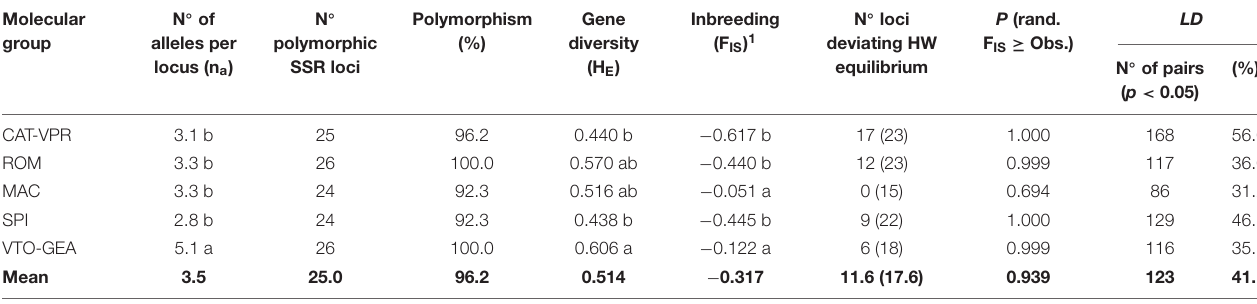
TABLE 2 | Descriptive genetic statistics for the five SSR groups identified within the gene pool of the cultivated globe artichoke according to the Structure and DAPC analyzes. Molecular N ◦ of group alleles per locus (n a )